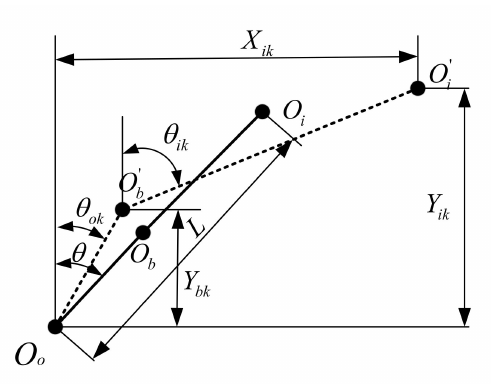
Figure 5. Timoshenko beam element.